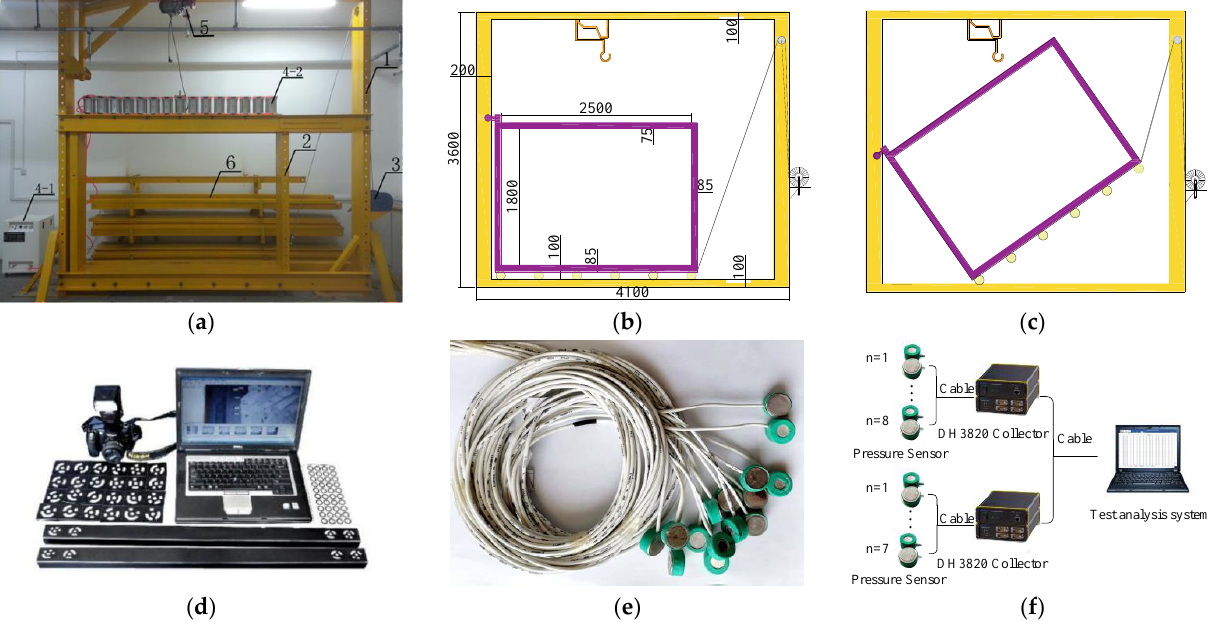
Figure 2. Servo loading experimental system for strata control in steep/thick coal seam. ( a ) System characteristics; ( b ) model frame parameters; ( c ) rotation model; ( d ) three-dimensional photogram- metry system; ( e ) pressure sensor; ( f ) stress monitoring equipment and process.